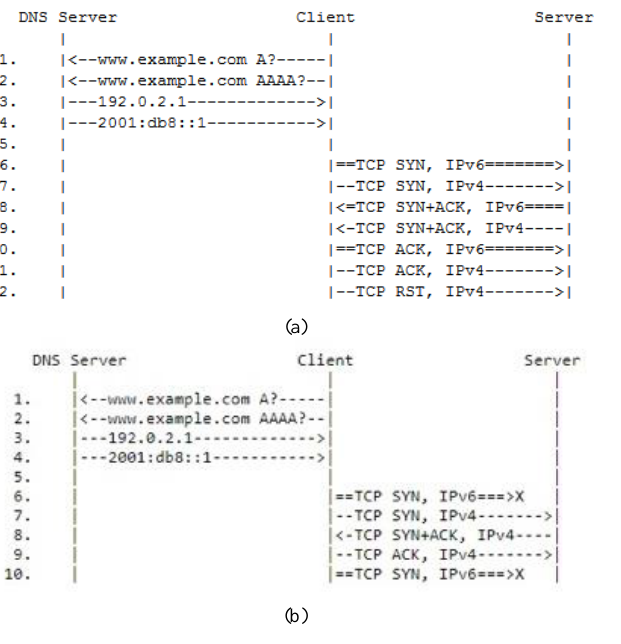
Fig. 4. Happy Eyeball Scenario: (a) Successful IPv6; (b) Broken IPv6 [9]